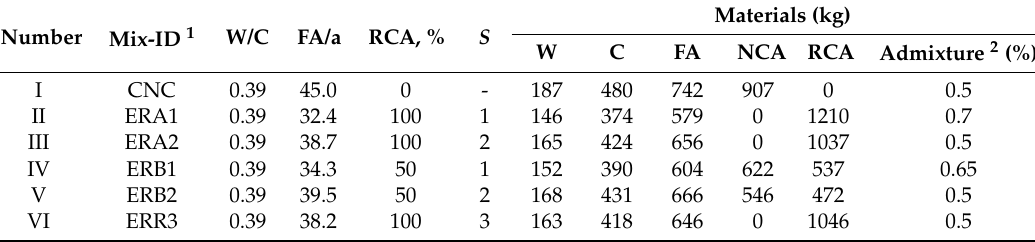
Table 3. Mix proportion of concrete per 1 m 3 ; W/C: Water to cement ratio; FA: Fine aggregate; NCA: Natural coarse aggregate, a: Total aggregate (FA+NCA+RCA).